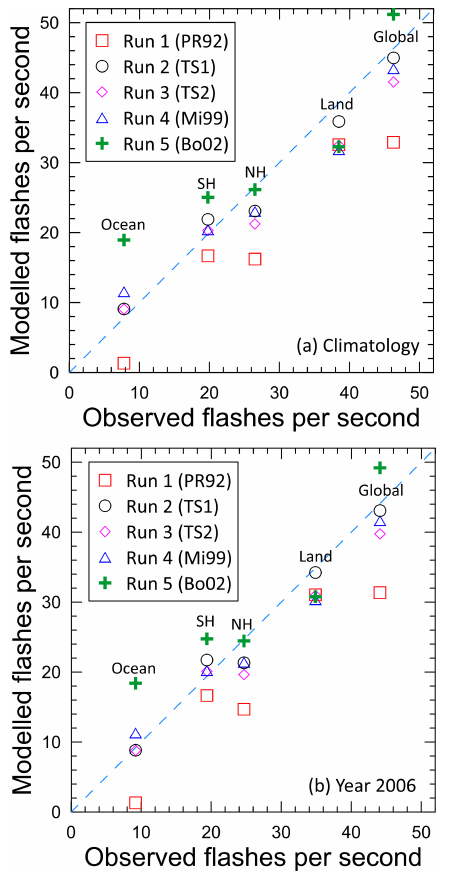
Figure 2. Observed vs. modelled flash rates from the five model runs (corresponding to PR92, TS1 and TS2, Mi99, and Bo02) con- ducted for the year 2006. The vertical clusters of points are the val- ues over the globe, ocean, land, Southern Hemisphere (SH), North- ern Hemisphere (NH). (a) The observations are the LIS/OTD cli- matological data, and (b) the observations are the LIS data for the year 2006 that are available for the latitude range ± 42 . 5 ◦ (with the modelled values also corresponding to this